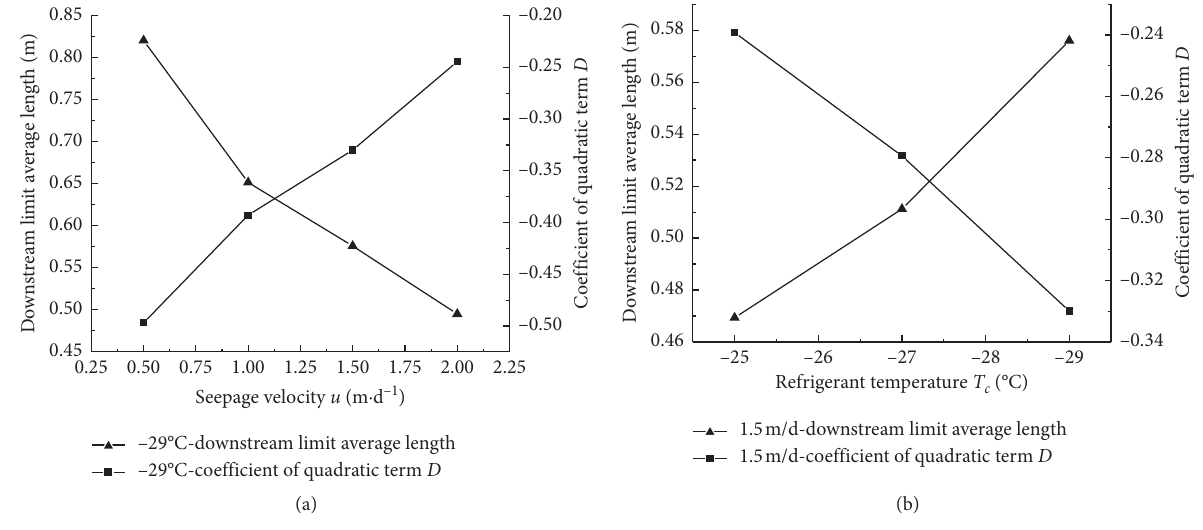
d . (b) Refrigerant temperature